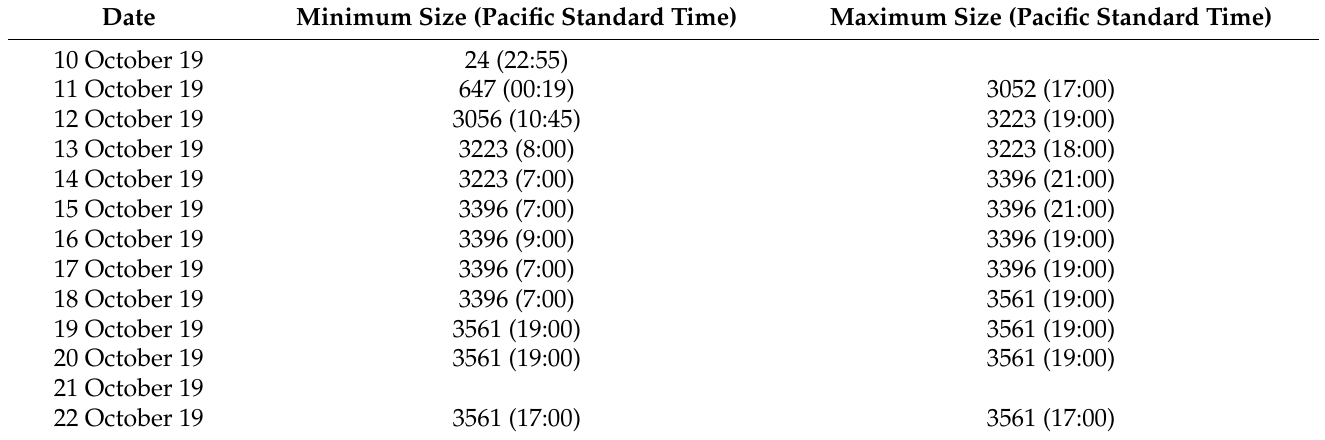
Table 3. Supplemental BATS data for the Saddleridge fire (2019) from the Los Angeles Fire Depart- ment (https://www.lafd.org/news/saddle-ridge-brush-fire; Accessed on 27 September 2022). Daily size is reported in hectares. The local time of the narrative are reported in the